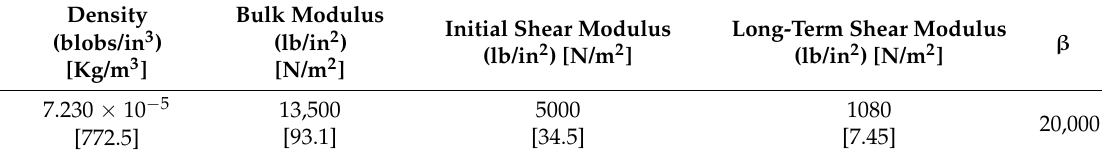
Table 5. Ball material properties.